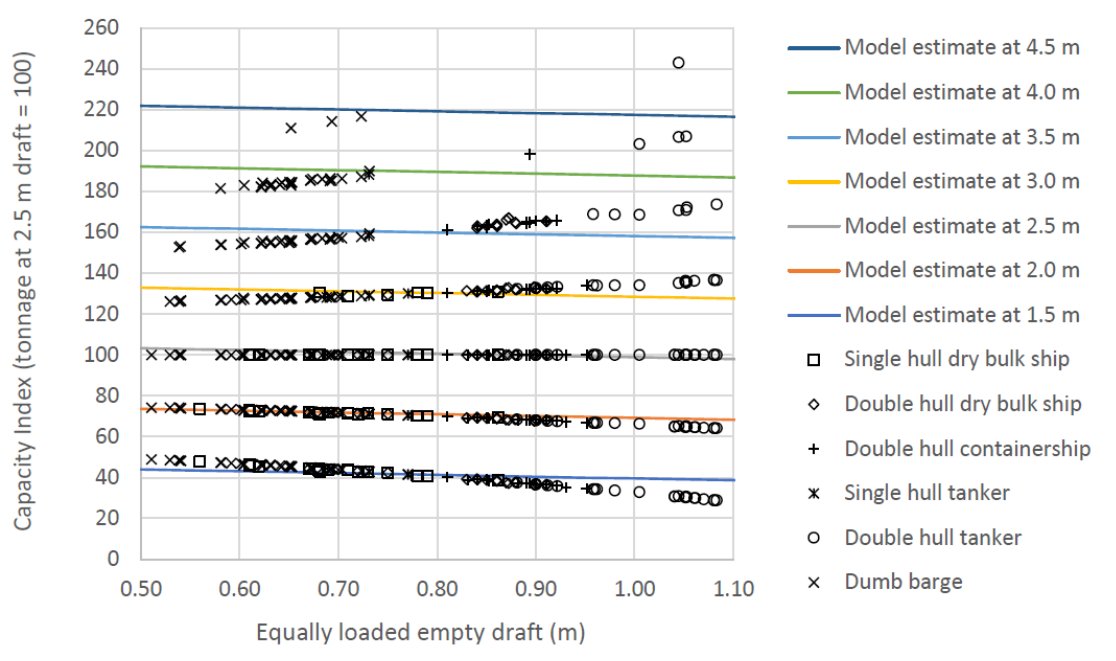
Figure 5. Observed fit of the first regression model for capacity index